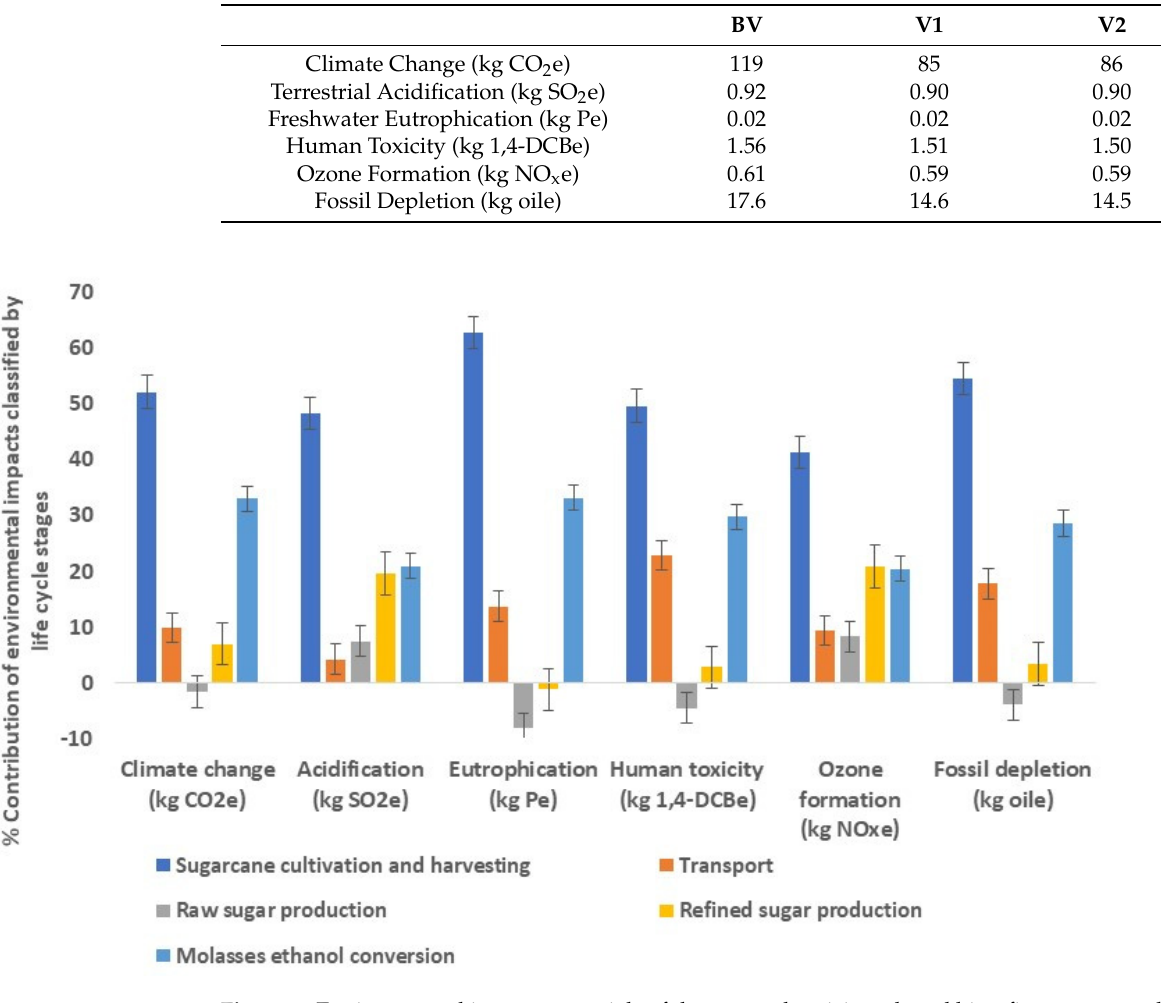
Figure 3. Environmental impact potentials of the sugar-electricity-ethanol biorefinery system fied by life cycle classified by life cycle stages.